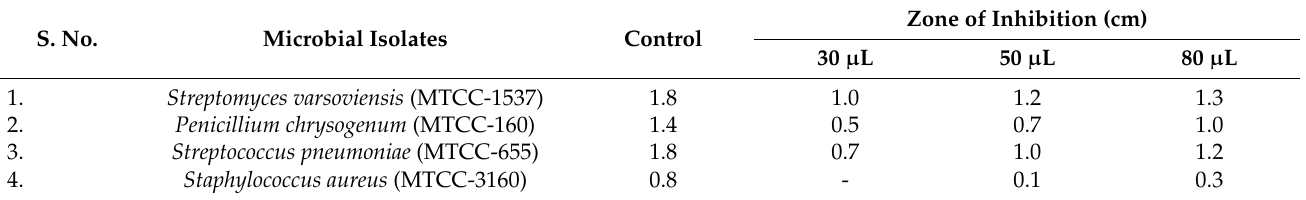
Table 3. Antimicrobial activity of Priestia aryabhattai (H3)-synthesized Ag NPs against selected human pathogens.